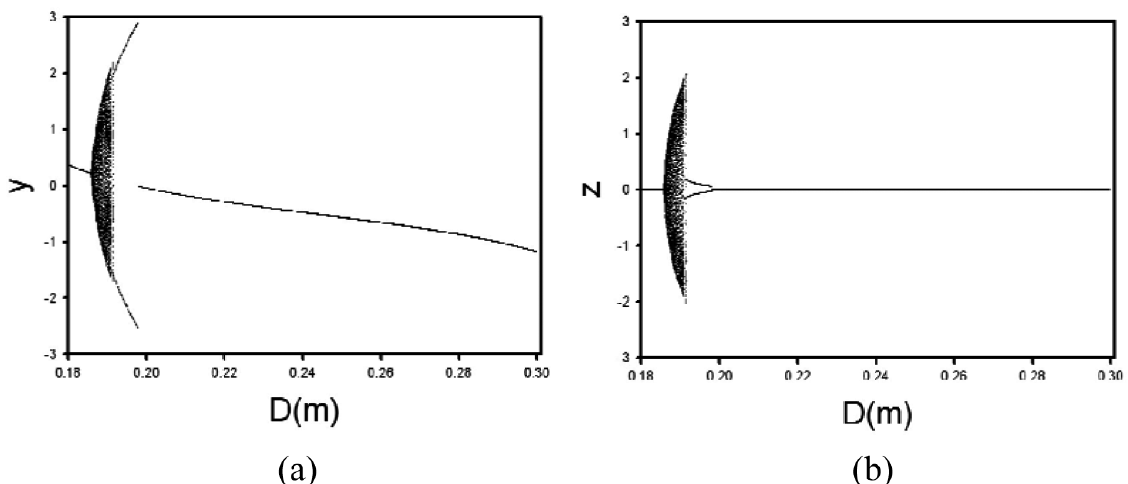
Fig. 21. The bifurcation diagram of displacements at the mid-span point versus diameter of journal. (a) y -displacement; (b) z -displacement. ω = 500 rad/s, γ m = 500 T 2 m/H, ρ s = 7800 kg/m 3 , E = 206 GPa, C = 0.001 D , C e = D /1600, L = 3 m, L b = D /4, e ¯ m = 0 . 0001 m, x a = 0.08, x b = 0.92, μ o = 0.001 Pa ·